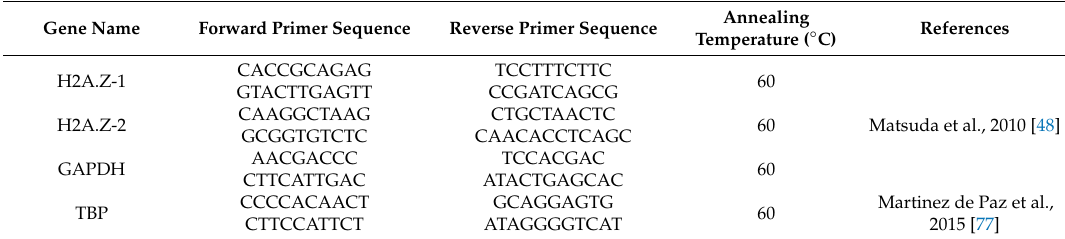
Table 1. Mouse RT-qPCR primer sequences used in the